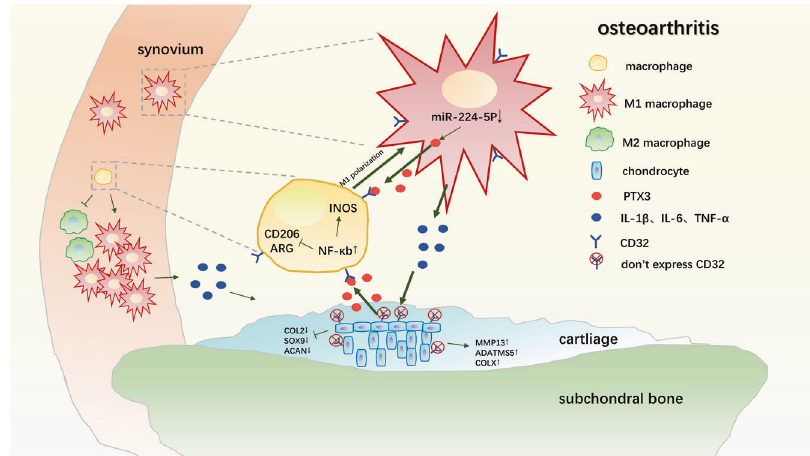
Fig. 7 Model of PTX3 regulation of synovial macrophage polarization and disrupted chondrocyte homeostasis during OA. Decreased miR-224-5p promotes M1-polarized OA macrophage and chondrocyte secretion of PTX3. Increased PTX3 promotes increased M1 polarization of synovial macrophages and the secretion of in fl ammatory cytokines that disrupt chondrocyte homeostasis, accelerating OA